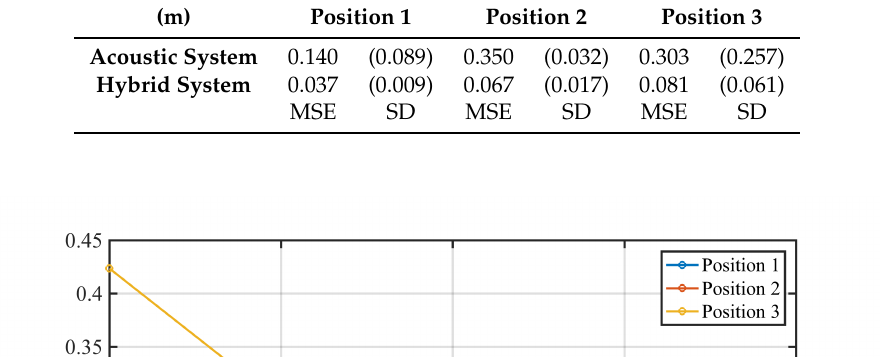
Table 1. Mean Squared Error (MSE) and its Standard Deviation (SD) in each position under study.